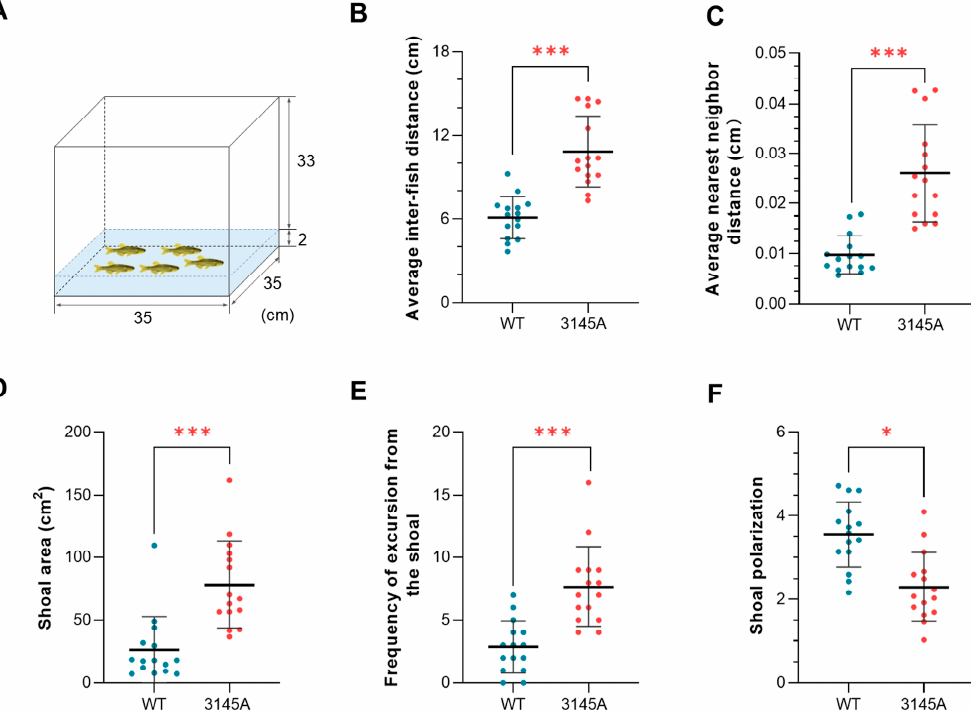
Figure 6. Deficiency in Prkcaa impaired the shoaling behavior of zebrafish. ( A ) An illustration of the shoaling test. The numbers indicate the size of the tank (cm). ( B ) Average interfish distance. ( C ) Average nearest neighbor distance. ( D ) Shoal area. ( E ) Frequency of excursion from the shoal. ( F ) Shoal polarization. The fish were analyzed in groups (each group included 5 individuals), and 15 groups were analyzed for each of the fish lines. The error bars represent standard error ( n = 15). *, p < 0.05; ***, p < 0.001.